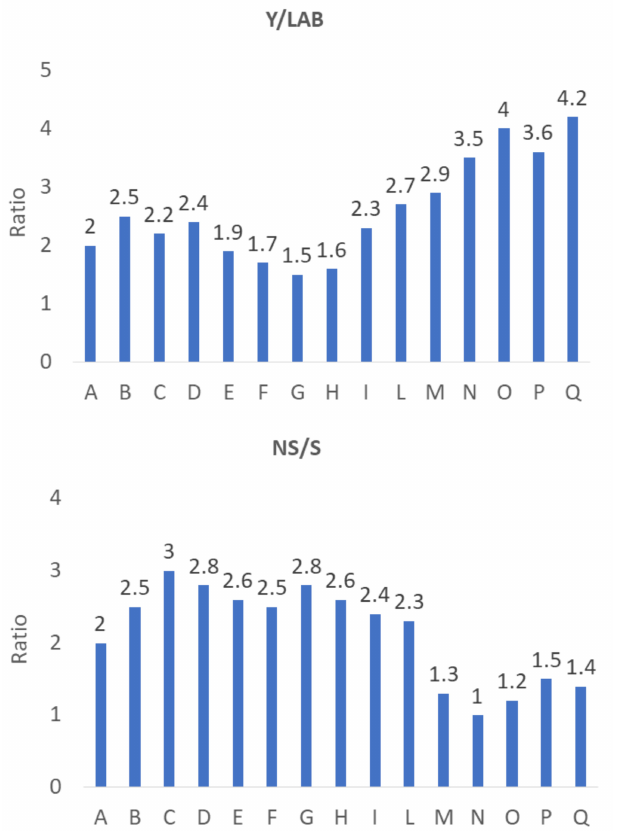
Figure 1. Ratio between yeasts and lactic acid bacteria (Y/LAB) and between “non- Saccharomyces ” and “ Saccharomyces ” strains (NS/S) in table olives collected in eight different areas at the end of a natural and spontaneous fermentation process. For the meaning of codes A-Q see Table